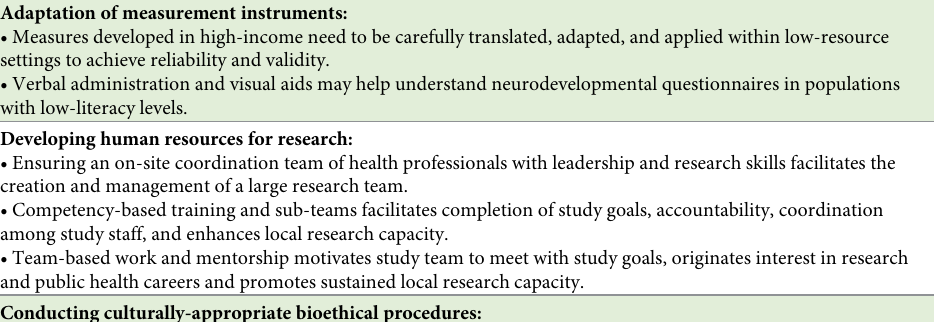
Table 3. Lessons learned /